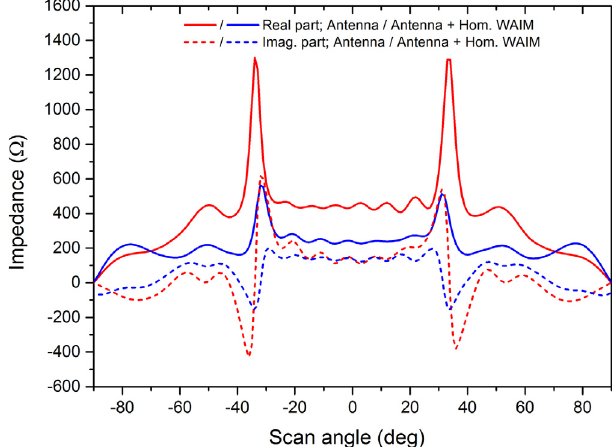
Figure 7. E-plane scan reflection coefficient for the central element vs. frequency and angle of incidence in the presence of the homogenous WAIM slab (scale is in decibels). Dashed white lines is the theoretical onset of the first grating